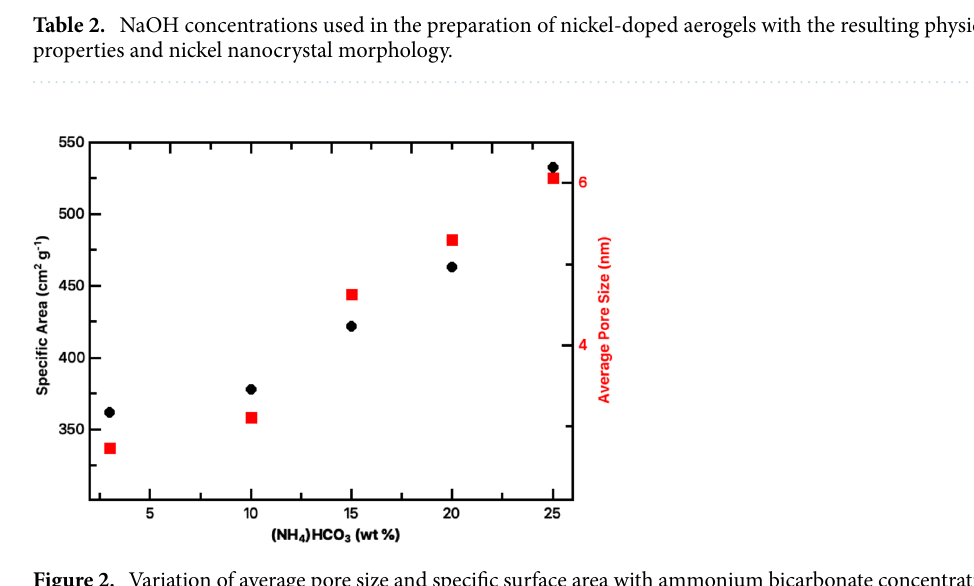
Figure 2. Variation of average pore size and specific surface area with ammonium bicarbonate concentration in undoped silica